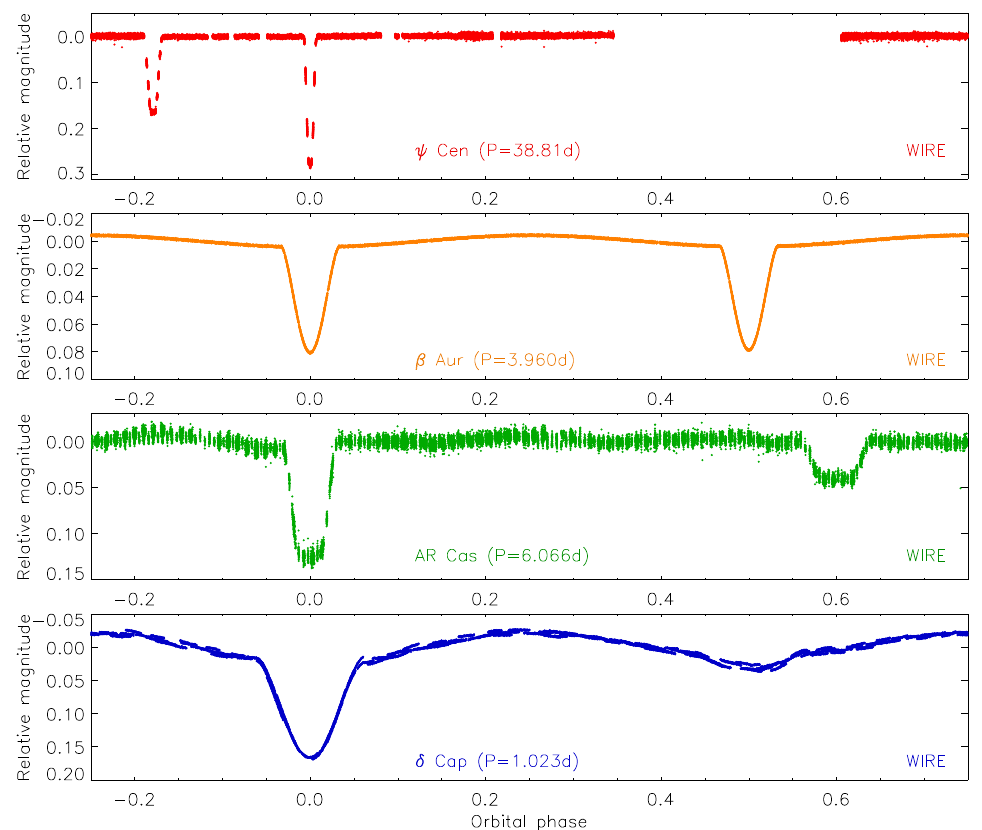
Figure 4. The WIRE satellite light curves of four EBs (labelled) plotted according to orbital phase. The EB system µ Eri, containing a pulsating star, was observed using MOST (Jerzy- kiewicz et al. [95]). A total of 31 frequencies were measured, two eclipses were analysed, and the physical properties of the primary star determined. The frequencies were inferred to be of the SPB type. Another pulsating system observed using MOST is δ Ori A, which was found to show tidally perturbed g-mode oscillations at 12 different frequencies in the primary star (Pablo et al.